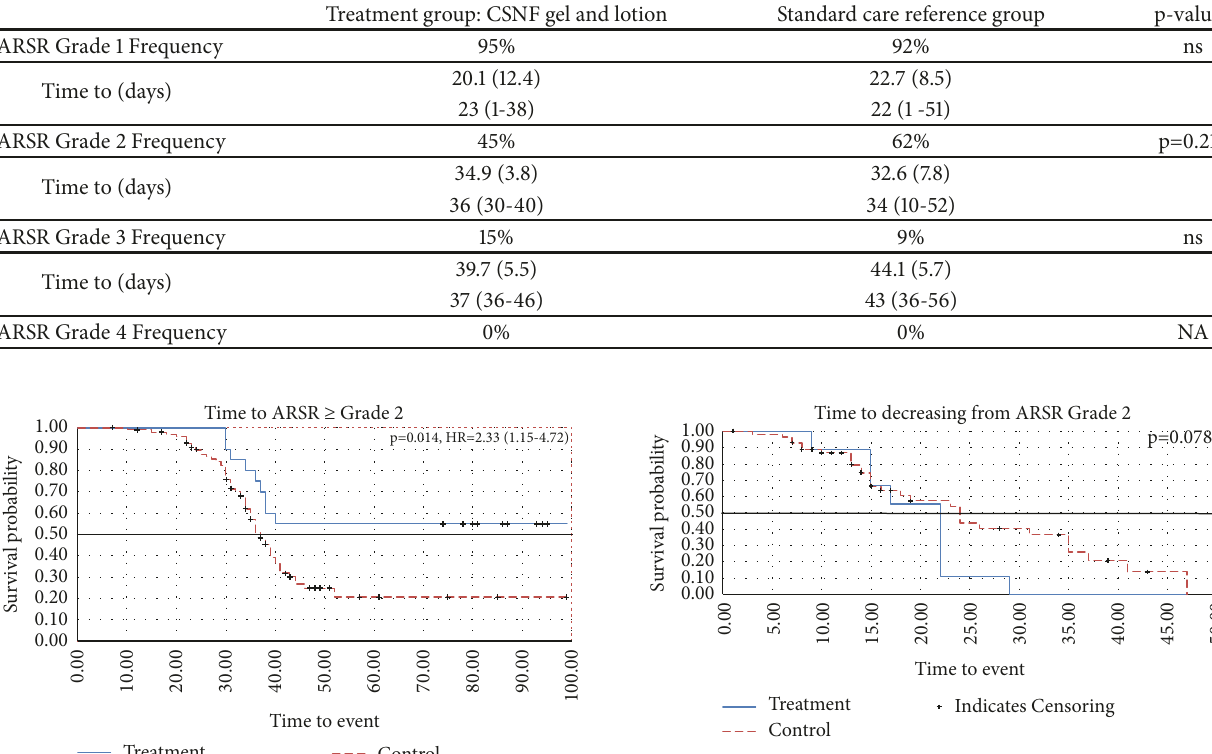
Figure 2: Time to recovery from ARSR Grade 2. p=0.078. Cen- soring: patients without documented event will be censored at the date of the last reported visit date. Patients having discontinued the radiotherapy without documentedeventwill be censored at the date of discontinuation. If no discontinuation date is reported, the visit date will be taken as censoring date instead. x-axis: months; y-axis: